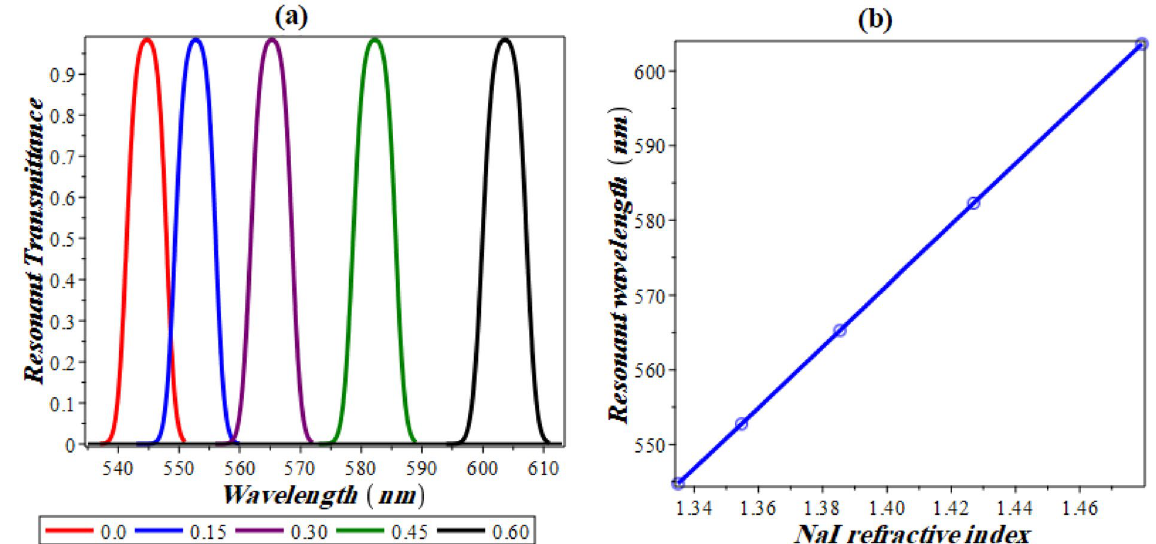
Figure 7. ( a ) Transmittance at resonance against wavelength for several NaI concentrations. ( b ) Resonant spectral position against concentration (or refractive index of